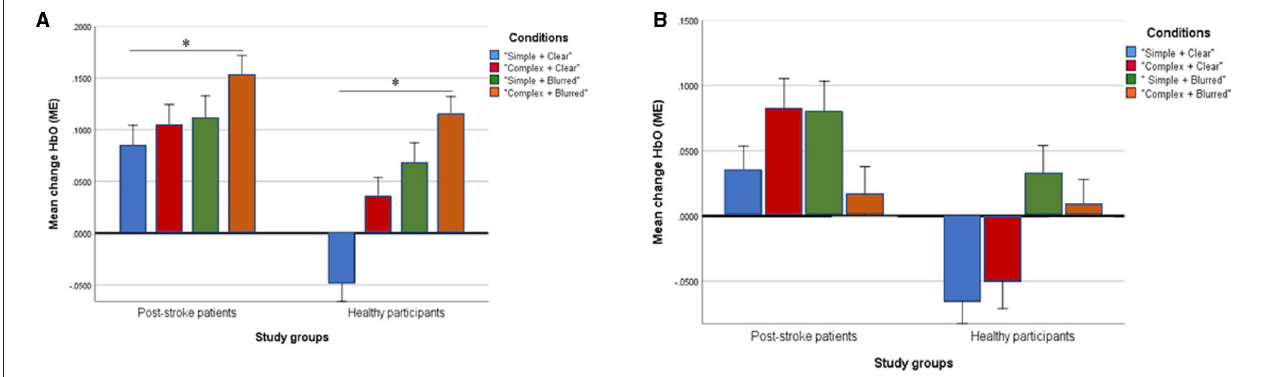
FIGURE 2 | Profile plots showing changes of mean [HbO] (ME) in ipsilesional/ipsilateral M1 (A) and contralesional/contralateral M1 (B) in four experimental conditions between post-stroke patient and healthy groups (unit, µ Mol/L). *Signify statistical significance.